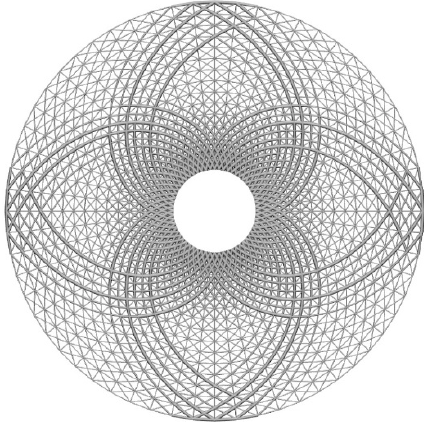
Figure 14. Final optimized structure of the hollow round.